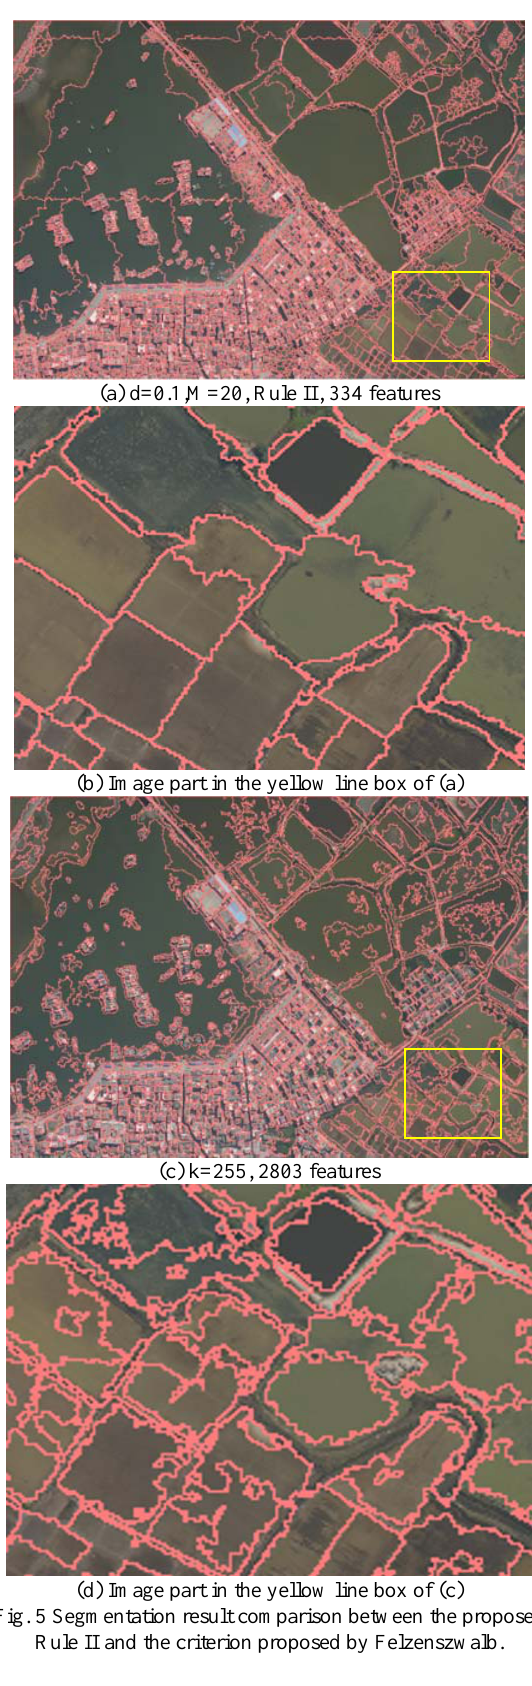
Fig. 4 Segmentation results by the Rule II.